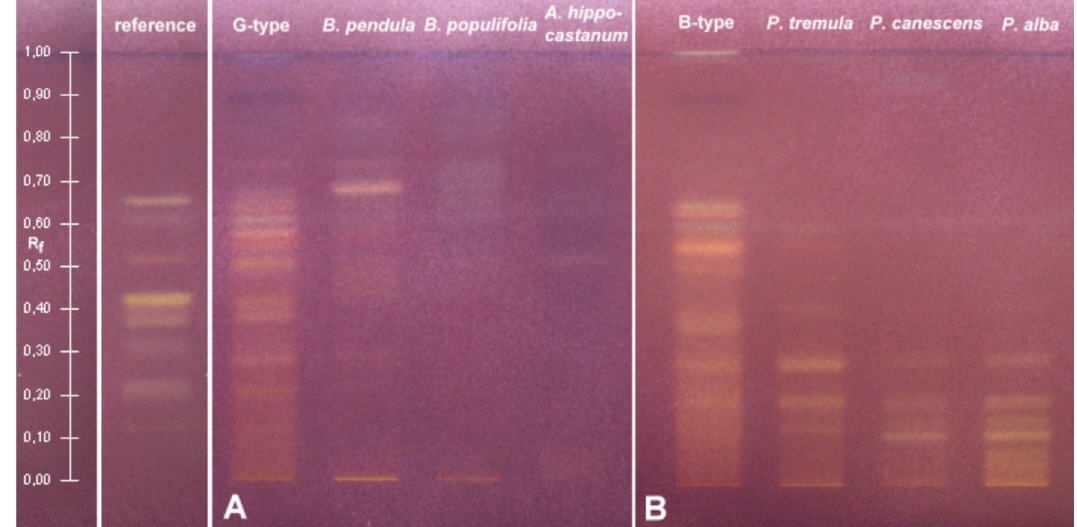
Fig. 7: TLC fingerprints of the DPPH experiment with (A) the G-type propolis with B. pendula Roth, B. populifolia Marsh. and A. hippocastanum L. bud extracts (each 30 μL) and (B) the B-type propolis and with P. tremula L., P. x canescens (Aiton) Sm. and P. alba L. bud extracts (each 40 μL). The applied volume for the reference was 40 μL.